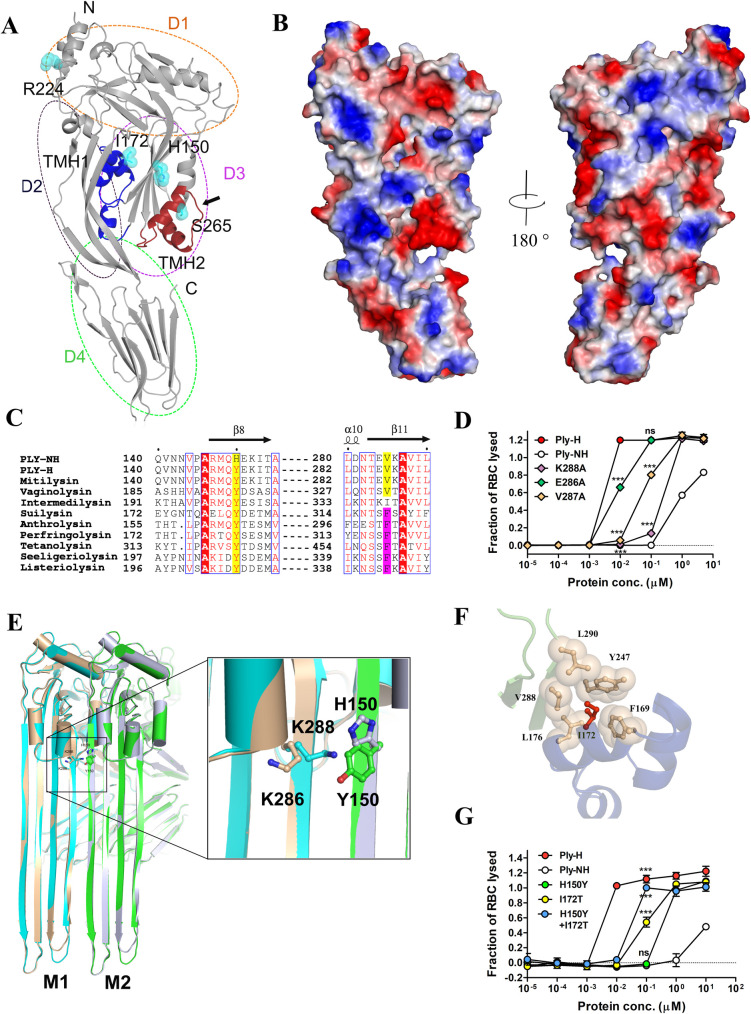
Loss of an essential cation-π interaction inhibits transmembrane β-hairpin (TMH) formation in Ply-NH.(A) Cartoon representation of Ply-NH crystal structure where individual domains are labelled as D1, D2, D3 and D4. The substitutions are represented as spheres along with ball and stick and colored according to elements (C-cyan, N-blue and O-red). The deletion is marked by black arrow. The TMH1 and TMH2 are also highlighted in blue and brown, respectively. (B) Electrostatic surface representation of Ply-NH. The blue and red indicate the electropositive and electronegative regions, respectively. (C) Multiple sequence alignment of CDCs highlighting the conservation of tyrosine (highlighted in yellow, Y150 in Ply-H) and phenyl alanine (highlighted in magenta, F318 in perfringolysin). (D) Hemolytic activity of Ply-H and its mutated variants (E286A, V287A and K288A) at different concentrations for identification of the potential β4 residue which pairs with Y150 from β1 of neighbouring monomer. (E) Cartoon representation of extended TMHs of two Ply-H/Ply-NH monomers (M1 and M2 colored cyan and green for Ply-H and brown and grey for Ply-NH, respectively) in the oligomerized state. Inset: Zoomed in view showing inter-molecular cation-π interaction between K288 and Y150 in Ply-H and its disruption in Ply-NH with H150 substitution. (F) Close up view of the hydrophobic pocket in domain-3 formed by F169, I172, L176, Y247, V288 and L290 residues, which are shown as both sphere and ball and stick style (wheat color). The I172 (ball and stick model in red color) is found to be stabilized in the hydrophobic pocket. (G) Concentration dependent hemolytic profile of Ply-NH and its mutants showing gain of hemolytic activity. Individual mutations H150Y and I172T in Ply-NH show some gain of hemolytic activity, notably the double mutant (H150Y+I172T) shows gain of most of the hemolytic activity. Data information: Experiments are performed thrice and data of representative experiments are presented as mean ± SD of triplicate wells (D, G). Statistical analysis was performed using one-way ANOVA with Tukey’s multiple comparison test vs Ply-H (D) or Ply-NH (G). ns, non-significant; ***p<0.001.